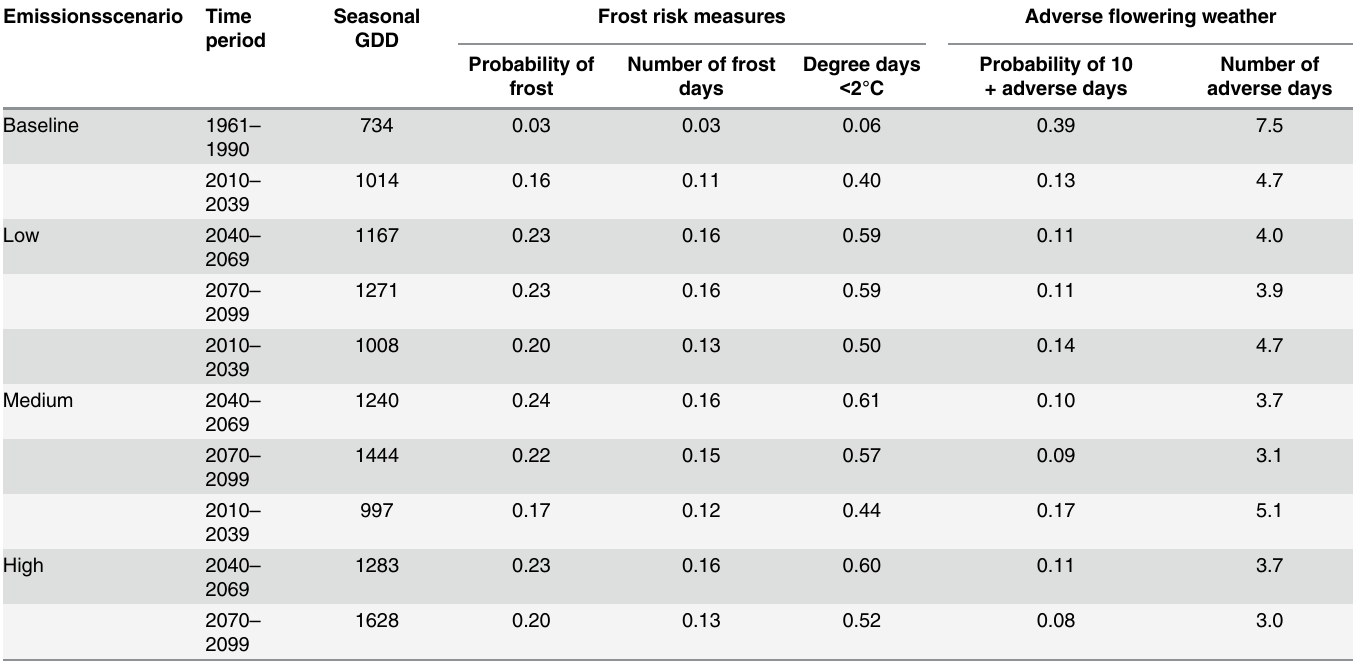
Table 3. Mean seasonal growing degree days, measures of late frost risk and of adverse flowering weather under different climate scenarios. Late frost risk expressed as (i) probability of a frost day (minimum temperature < = 0°C) after budbreak; (ii) mean number of these frost days, and (iii) mean accu- mulated degree days under 2°C after budbreak. Adverse flowering weather defined as a mean daily temperature < 15°C or total precipitation > 5mm and expressed as (i) the probability of 10 or more adverse days during the 7 days before and after flowering, and (ii) mean number of adverse days during the same 15 day period. The timing of budbreak and flowering calculated using spring warming